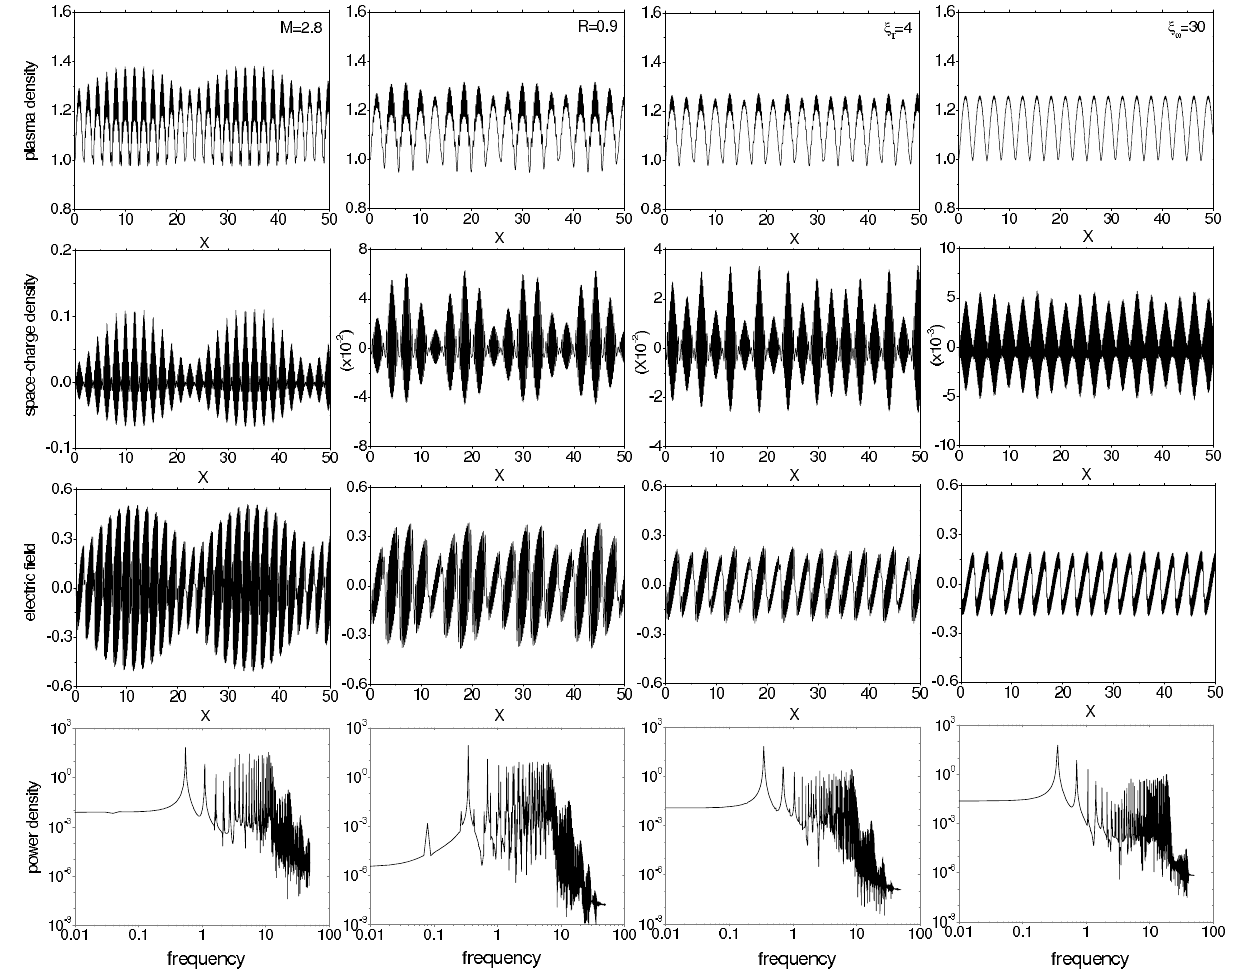
Fig. 8. Modulated oscillitons by input parameters M (left column), R (middle left column), ξ T (middle right column), and ξ ω (right column), respectively, in view of plasma density (top row), space-charge density (second row), electric field (third row), and FFT power density (bottom row),